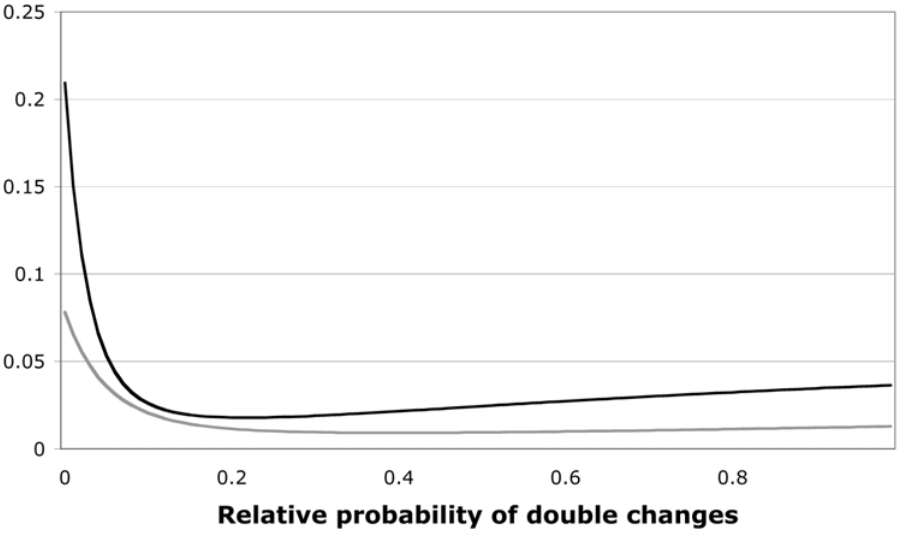
Figure 3. Probability of double changes and pathway repeatability. Path repeatability is shown as a function of the probability of double changes relative to single changes for forward mutations under both EVT (top trace) and truncating selection (bottom trace).